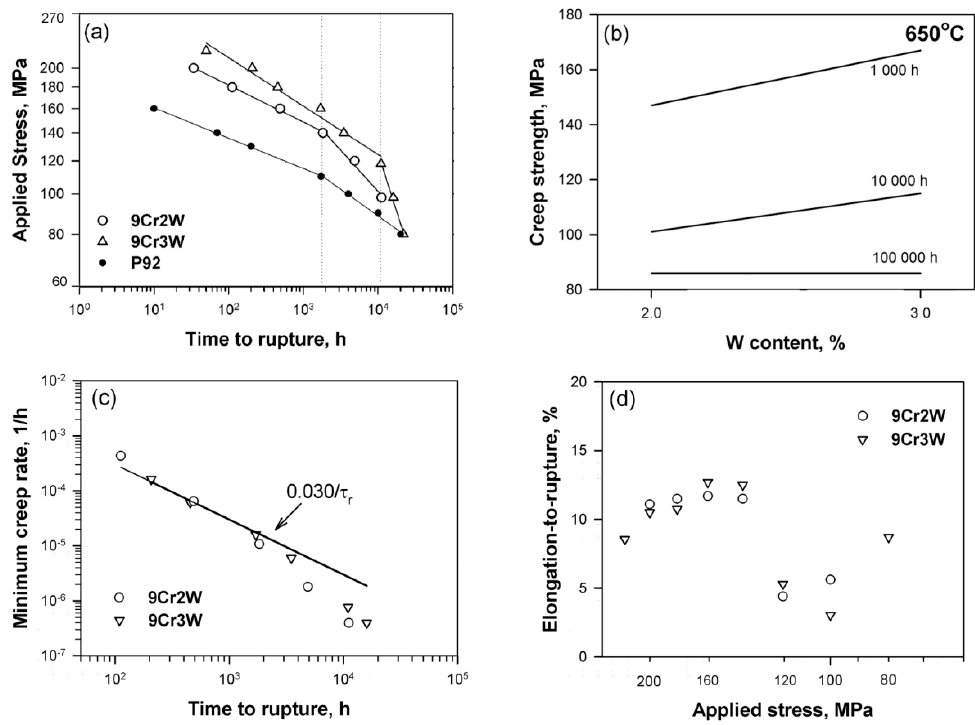
Figure 3. ( a ) Time to rupture vs. stress curves for the 9Cr2W and 9Cr3W steels in comparison with data for a P92 steel [2,7]; ( b ) the 1000 h, 10,000 h, and 100,000 h creep rupture strengths of steels at 650 °C as a function of W content; ( c ) minimum creep rate as a function of time to rupture for the 9Cr2W and 9Cr3W steels; and ( d ) applied stress vs. elongation-to-rupture for the 9Cr2W and 9Cr3W steels. The dotted lines in ( a ) indicate the time to rupture corresponding to the creep strength breakdown.